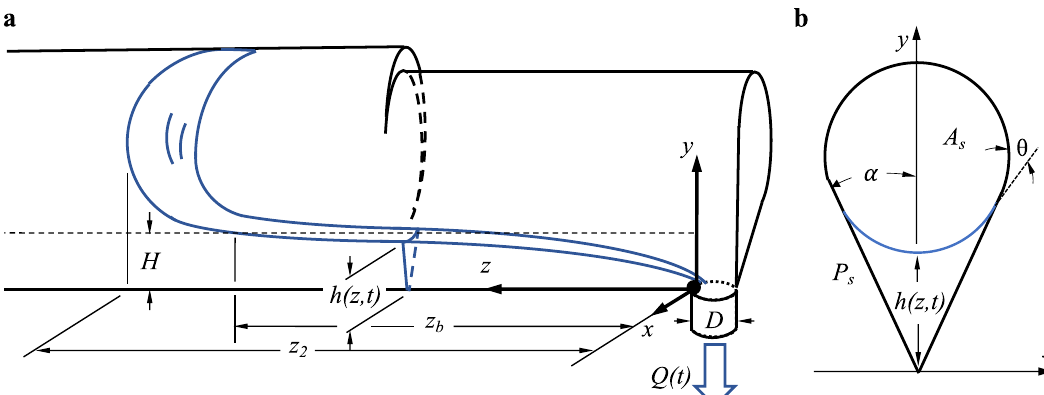
Fig. 4 Single drain de fi nition sketch. Single drain fl ow sketched for ICF-4: a Perspective pro fi le and b cross-sectional view. Drain diameter D = 4 mm for all ICF test